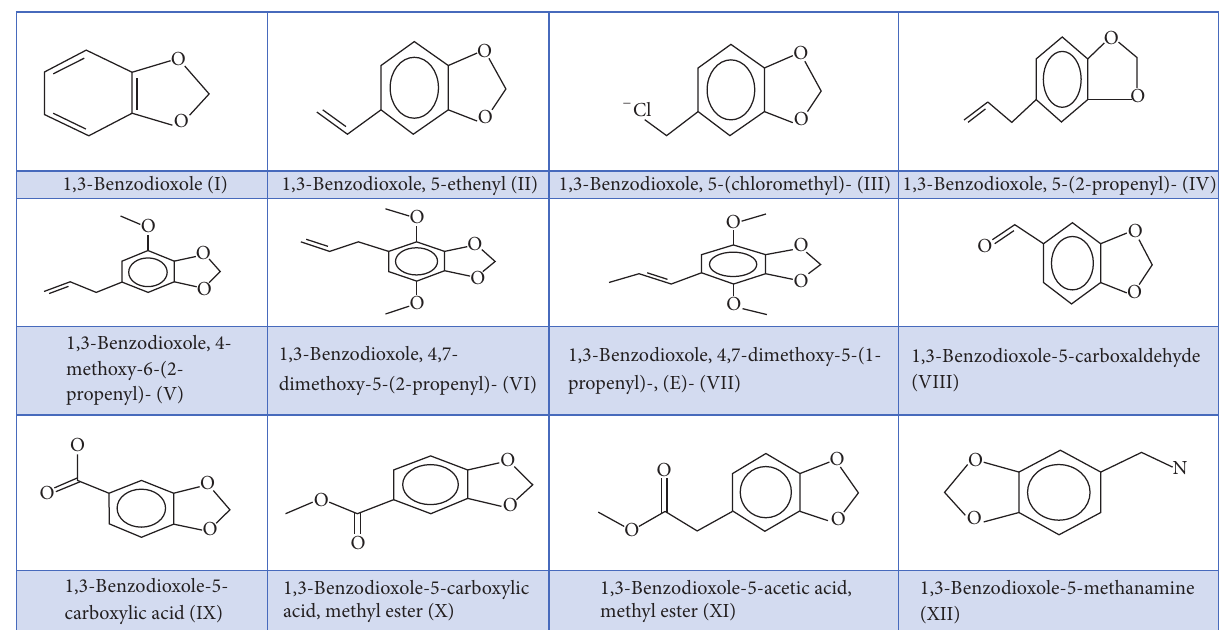
Figure 1: The molecular structure of the studied 1,3-benzodioxole